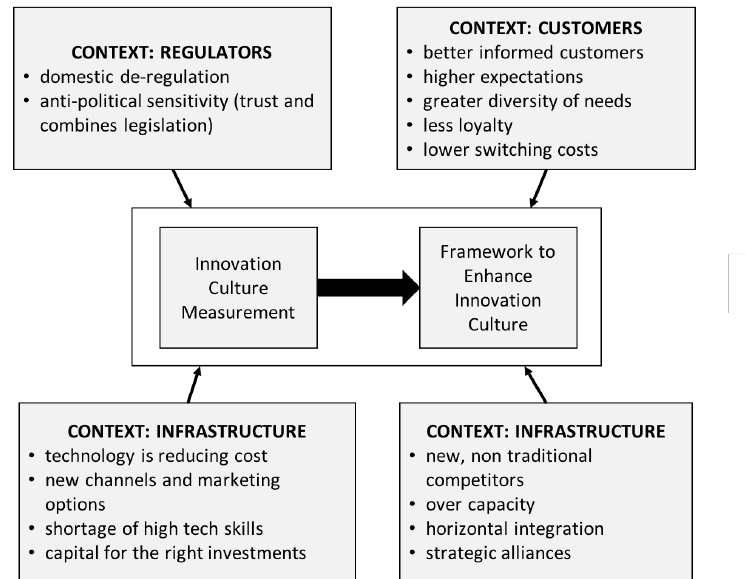
Fig. 2. Financial Services Industry Context (adapted from Dobni,